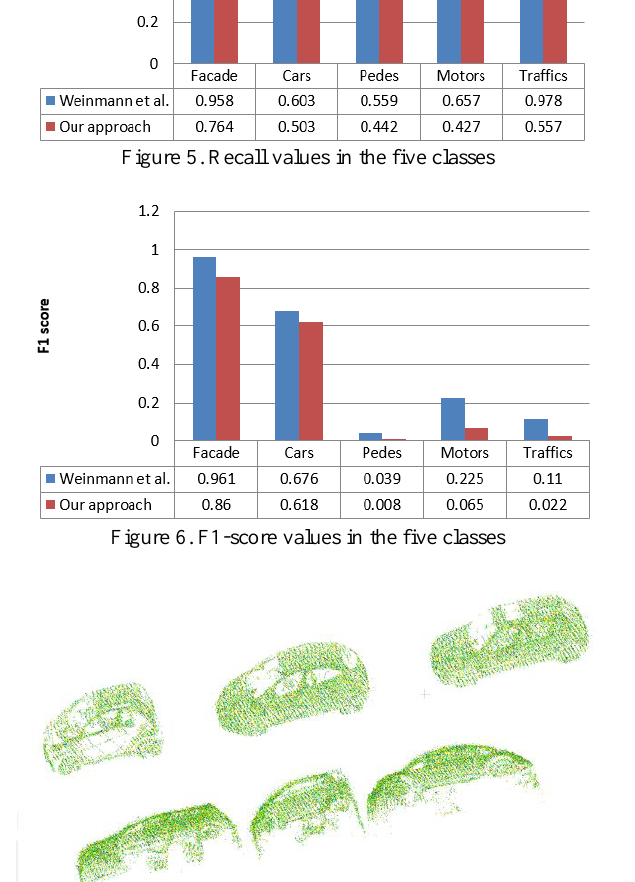
Figure 7. Classification of points reflected on cars; cars: green, façades: blue, motorcycles: orange, traffic signs: purple, pedestrians: